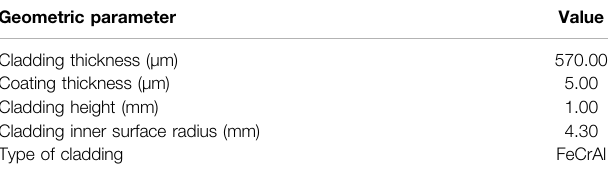
TABLE 1 | The parameters of geometry. Geometric parameter Value Cladding thickness ( μ